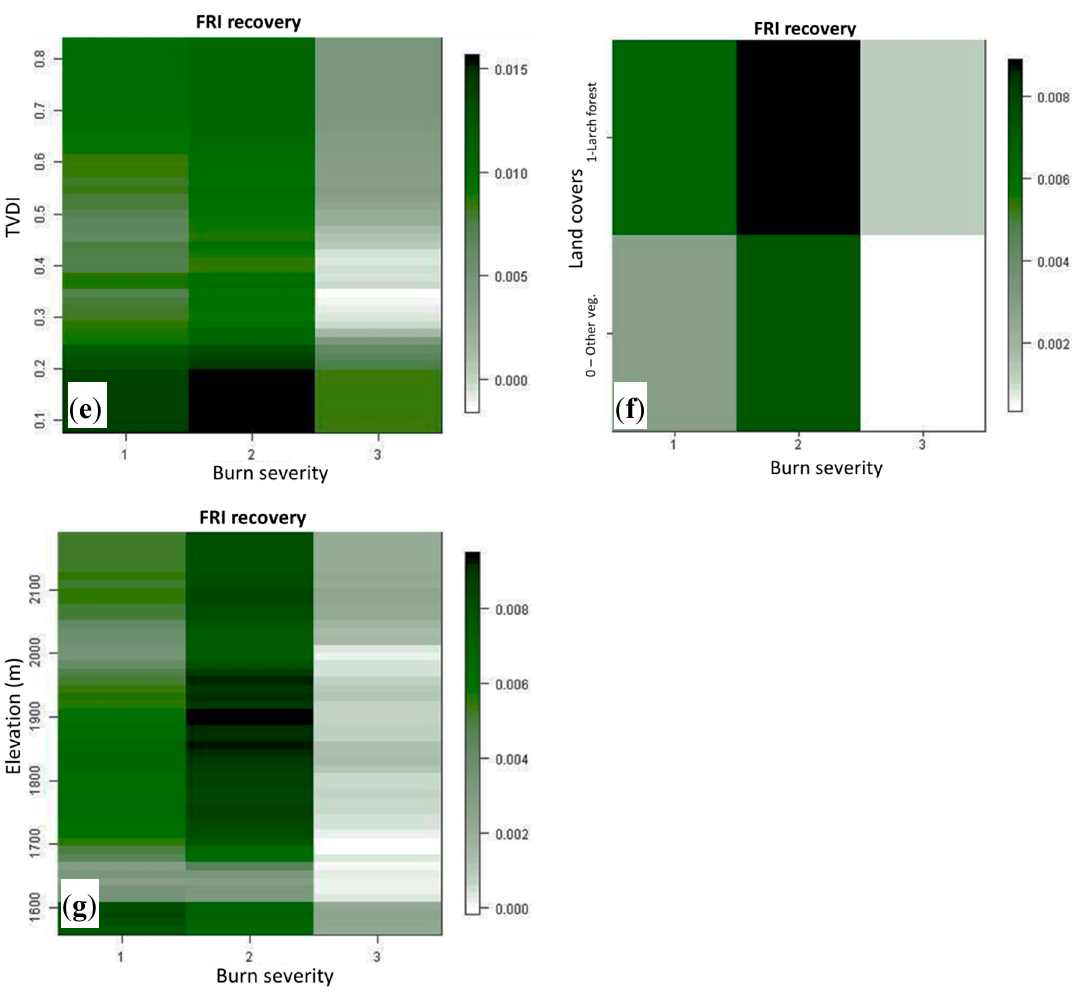
Figure 11. Interaction between burn severity and other factors ( a : burn severity and distance to water bodies; b : burn severity and pre-fire normalized difference vegetation index (NDVI); c : burn severity and solar insolation; d : burn severity and slope; e : burn severity and temperature - vegetation dryness index (TVDI); f : burn severity and pre-fire land covers; g : burn severity and elevation) in predicting post-fire forest recovery pattern defined by FRI. In each interaction plot, the unplotted predictor variables were fixed at their mean (for continuous predictors) or their mode (for categorical predictors). Values in the legends show the forest recovery rate measured by FRI